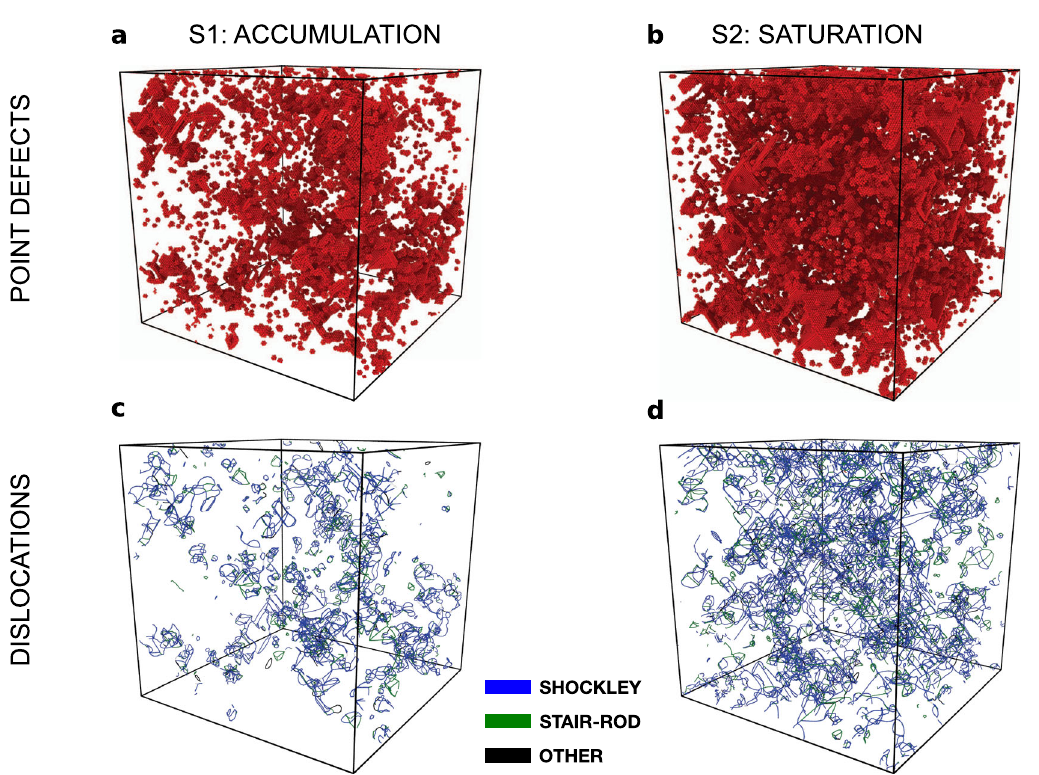
Fig. 2 Evolution of point defects and dislocations. Representative snapshots of a and b : point defects and c and d : dislocations in the 4- million-atom simulation cell within the two different stages of damage. In stage 1 (S1), the microstructures experienced a rapid accumulation of point defects and dislocations in a largely isolated fashion. In stage 2 (S2), the microstructures experienced a saturation point and mainly exhibited the coalescence of pre-existing defects into complex defect